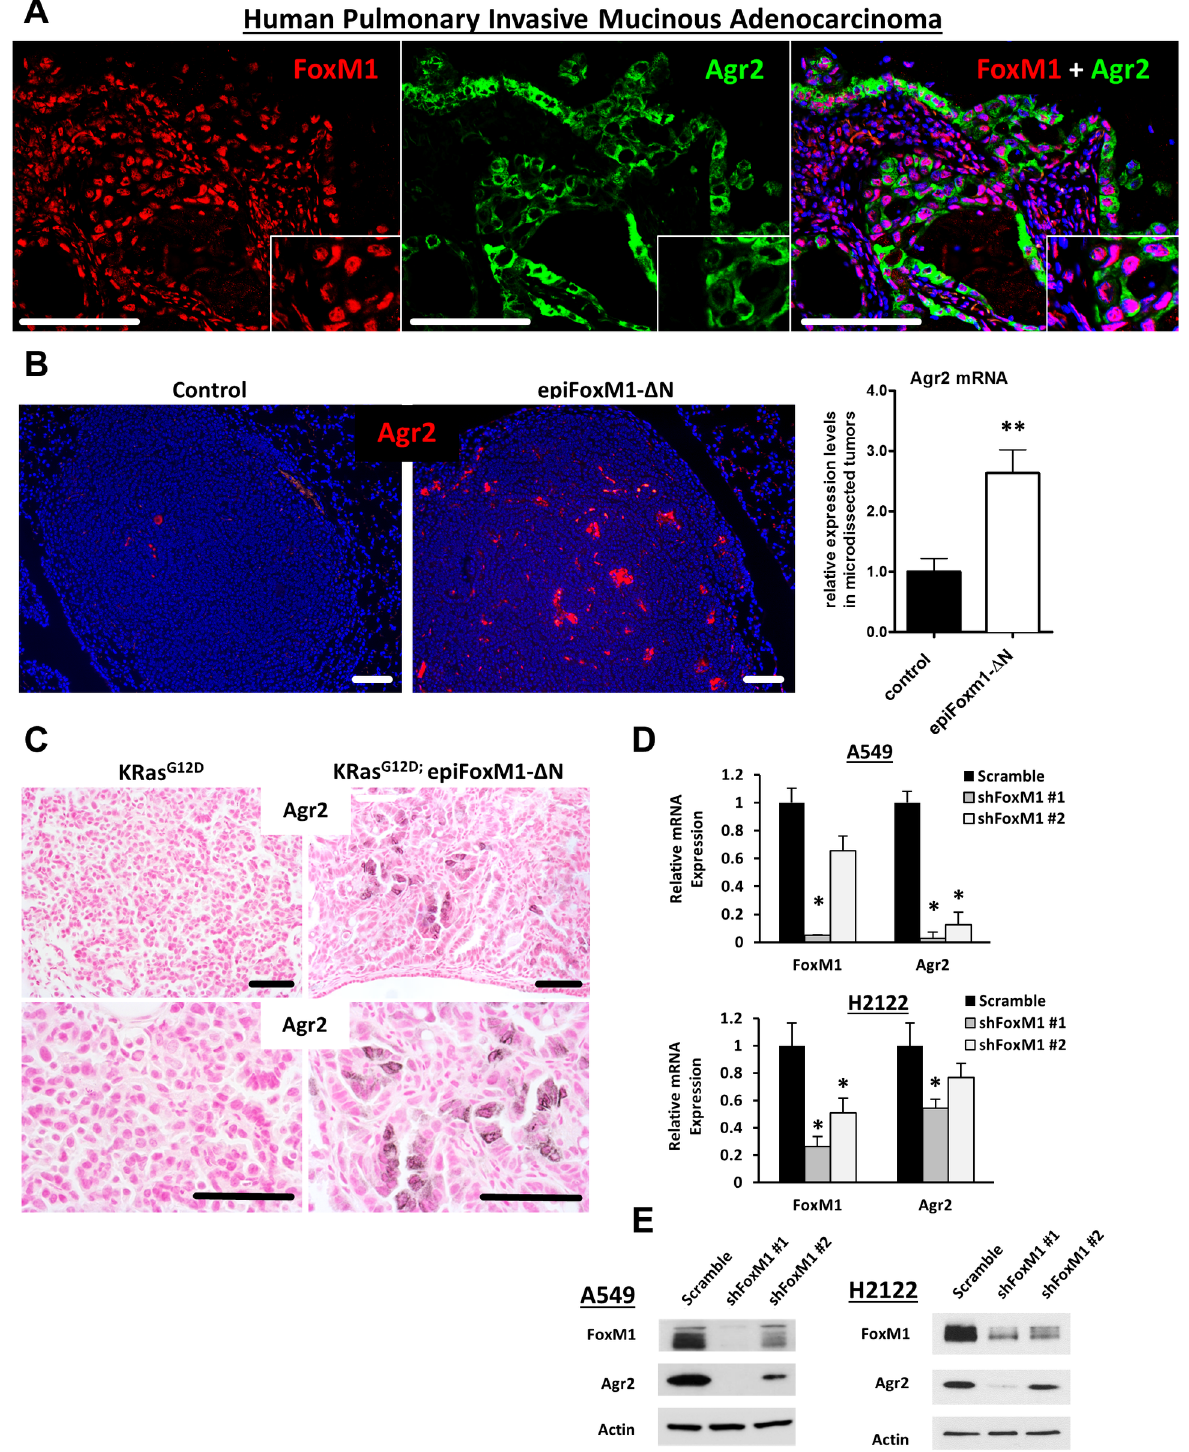
Fig 6. FOXM1 induces AGR2 in human and mouse lung adenocarcinomas. (A) In humanPIMAs, immunofluorescenceco- localization studies demonstrated that FOXM1-positive tumor cells were highlypositive for AGR2. (B ) In mouse urethane-inducedlung cancer model, AGR2 was inducedin epiFoxM1- Δ N tumors. Immunofluorescence stainingfor AGR2 in control and epiFoxM1- Δ N lung tumors (left panels,n = 6 control mice and n = 9 epiFoxM1- Δ N mice, ten images per each mouse lung) and qRT-PCR of Agr2 mRNA using RNA from microdissected control (n = 5) and epiFoxM1- Δ N (n = 5) lung tumors (right panel). β -actin mRNA was used for